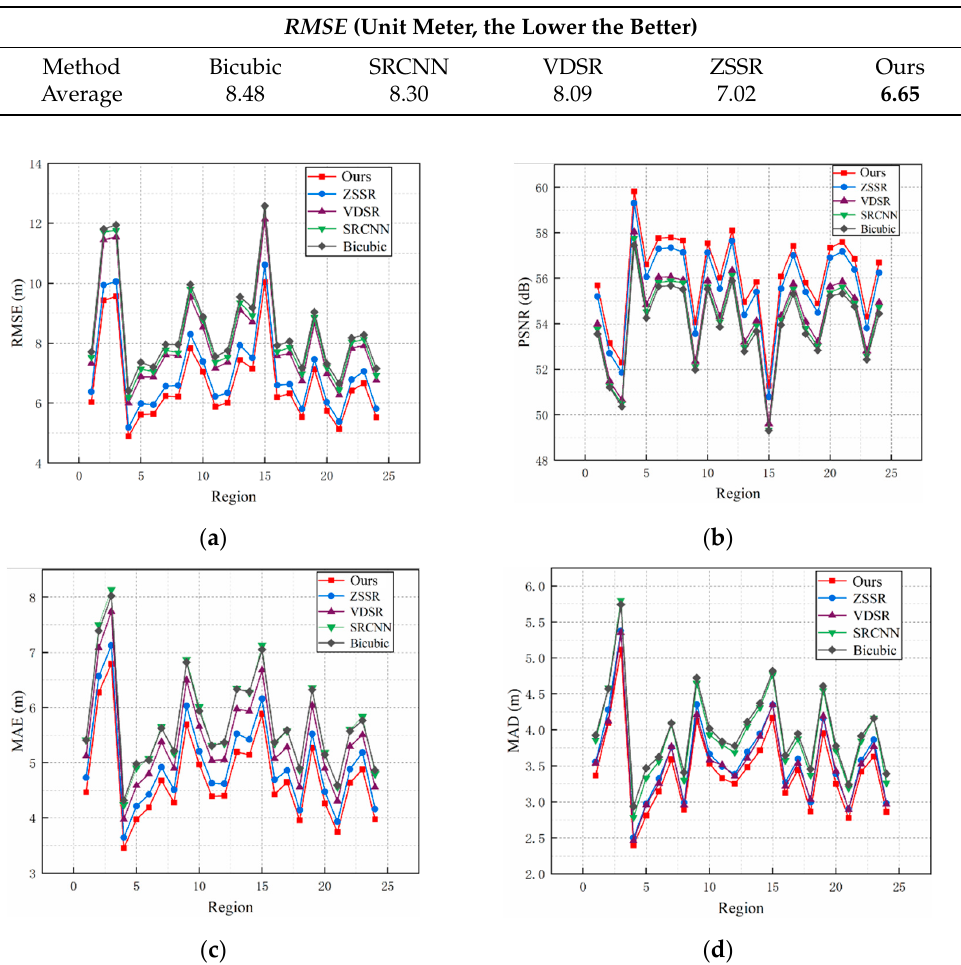
Figure 9. Quantitative results of different methods for the same region: ( a ) The visualization of the RMSE indicator; ( b ) The visualization of the PSNR indicator; ( c ) The visualization of the MAE indicator; ( d ) The visualization of the MAD indicator. Table 1. RMSE for the test regions.